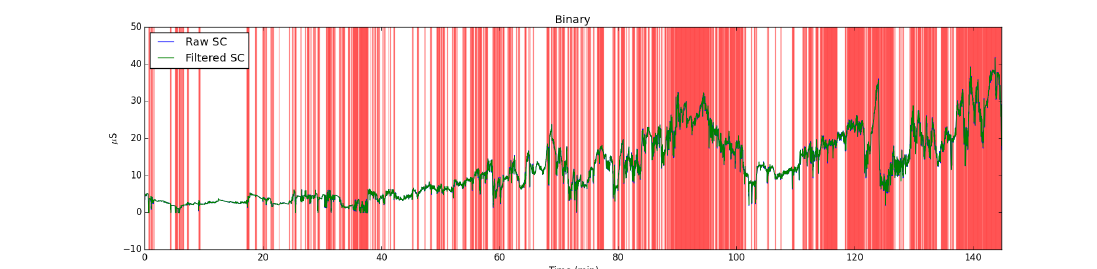
Figure 3. The example filtered EDA signal according to changes in the accelerometer signal. Note that red components were deleted because of the high activity intensity.